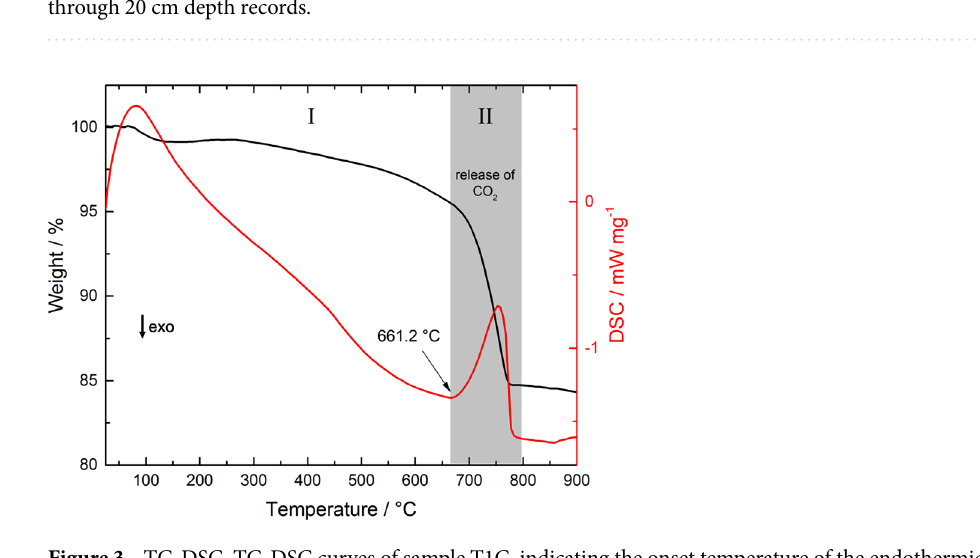
Figure 3. TG-DSC. TG-DSC curves of sample T1C, indicating the onset temperature of the endothermic event corresponding to the release of CO 2 . Similar thermograms are observed for the remaining